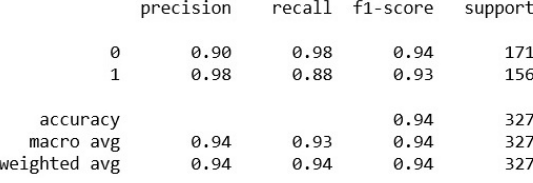
Figure 14. Classification report for the CNN-based